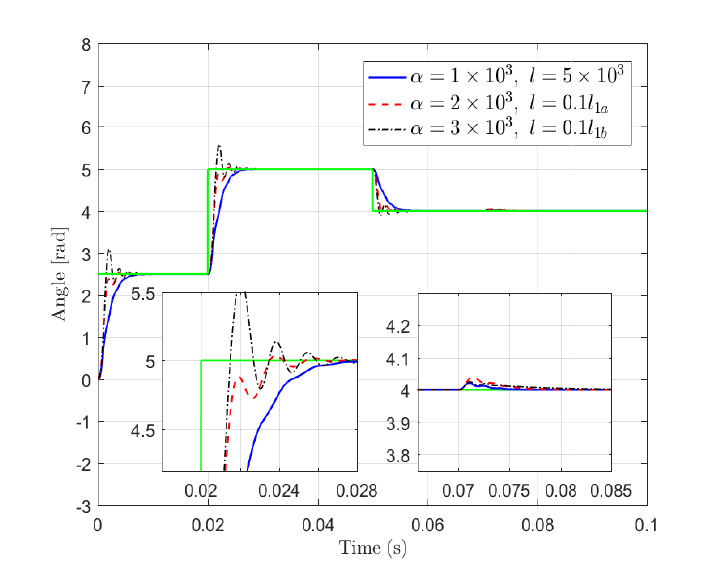
Figure 7. Performance improvement of ROPIO compensated ROMBC with lowered l according to α